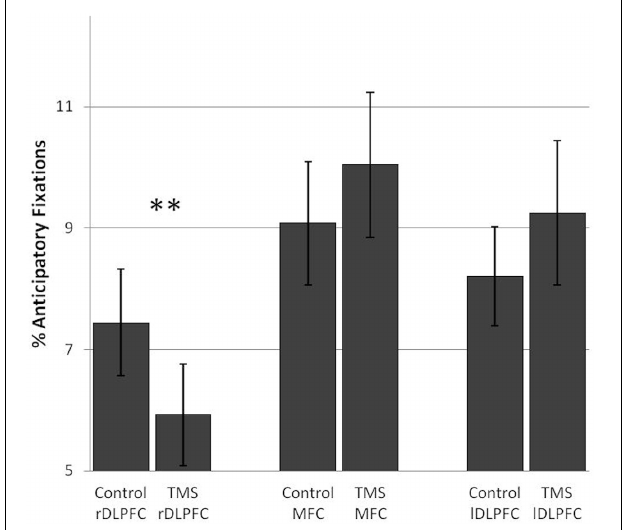
FIGURE 2 | TMS effects on the percentage of anticipatory fixations in the number search task. A significant difference in anticipatory fixations between the control and TMS condition was found after stimulation over the right dorsolateral prefrontal cortex. Error bars indicate standard errors of the mean (SE). ∗∗ 0.003.